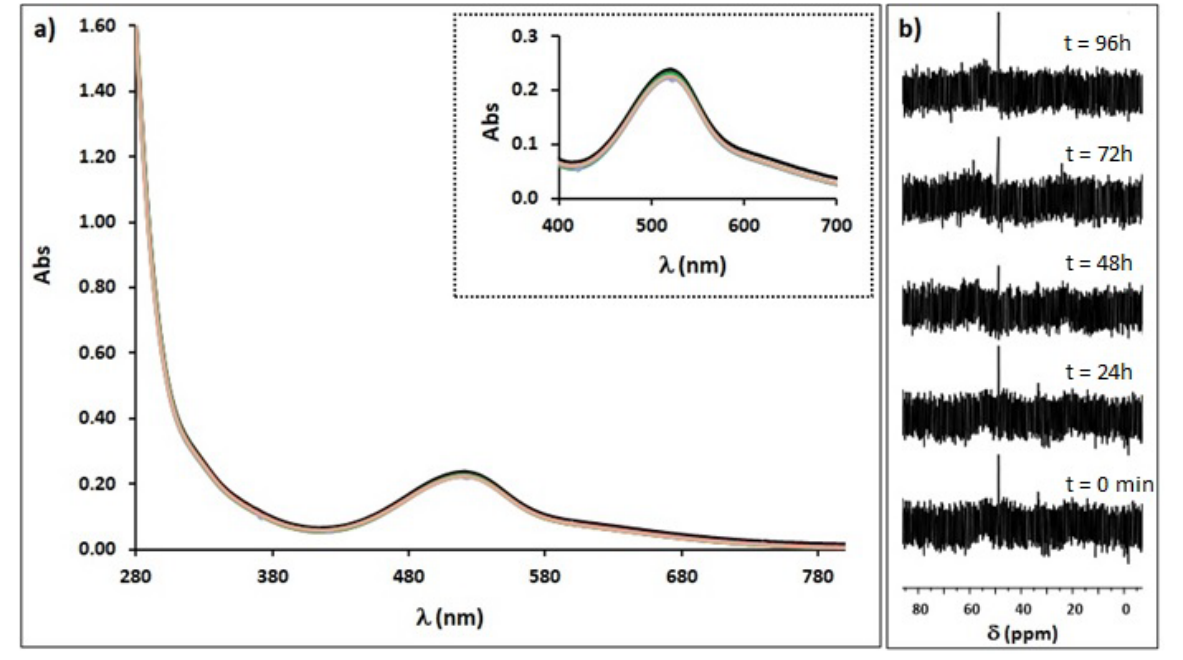
Figure 4. Evaluation of stability of complex 6 by ( a ) UV–vis spectroscopy over 48 h in H 2 O. Inset: detail of charge transfer band; ( b ) 31 P-NMR over 96 h in D 2 O.